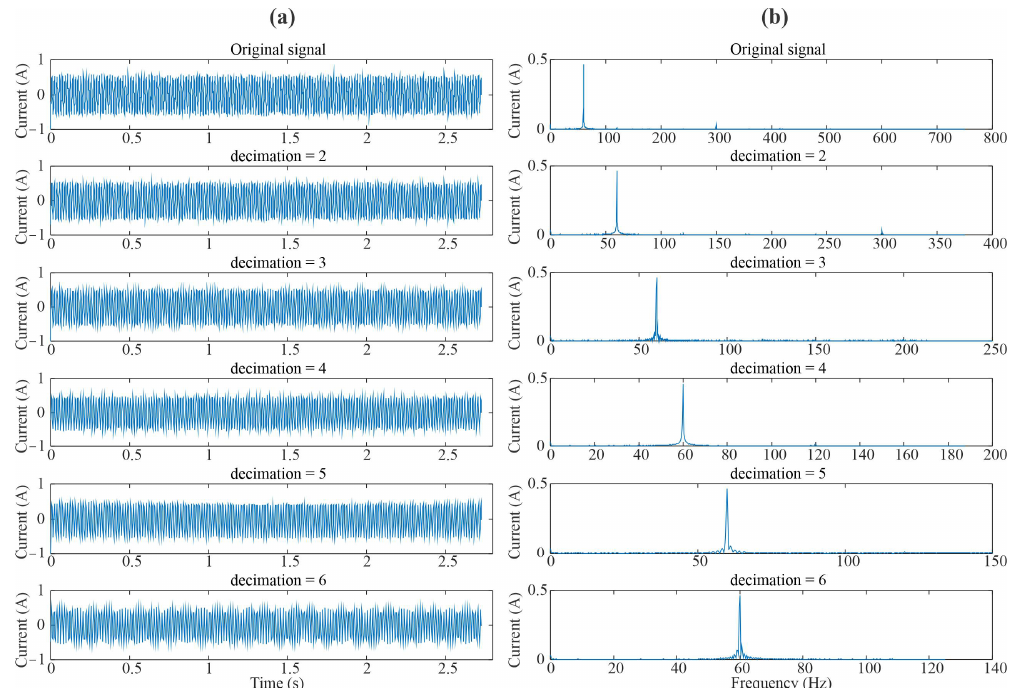
Figure 7. ( a ) Original and decimated current signals obtained using the start-up regime, and ( b ) their spectrums estimated by Fourier transform.